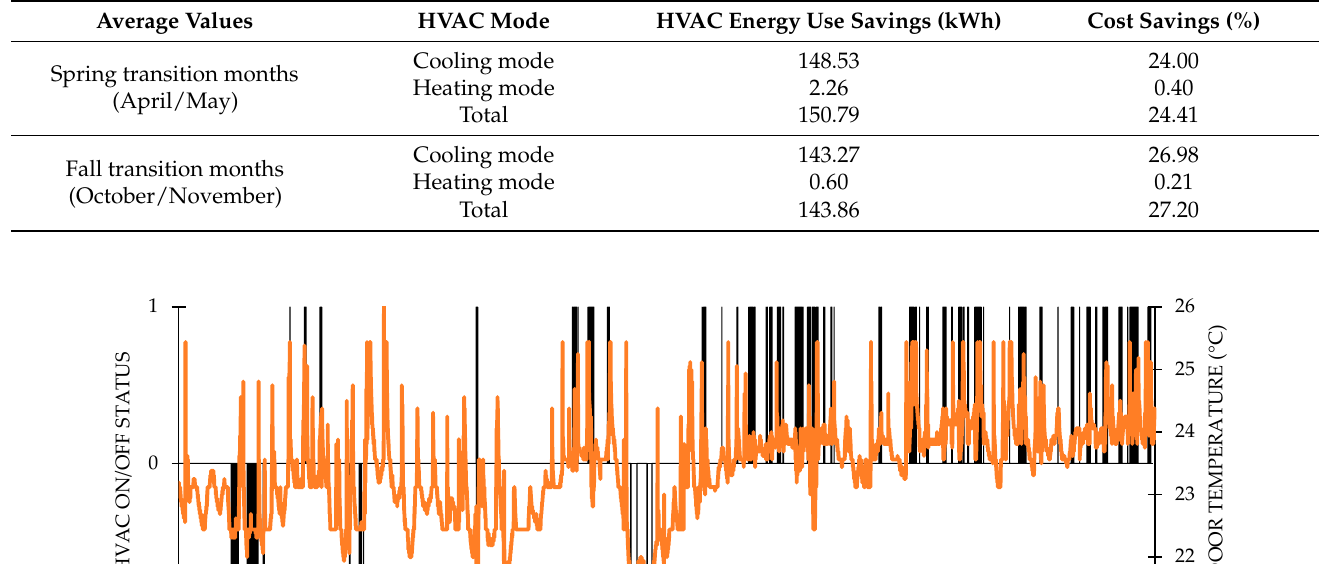
Table 3. Energy and economic benefit evaluation.